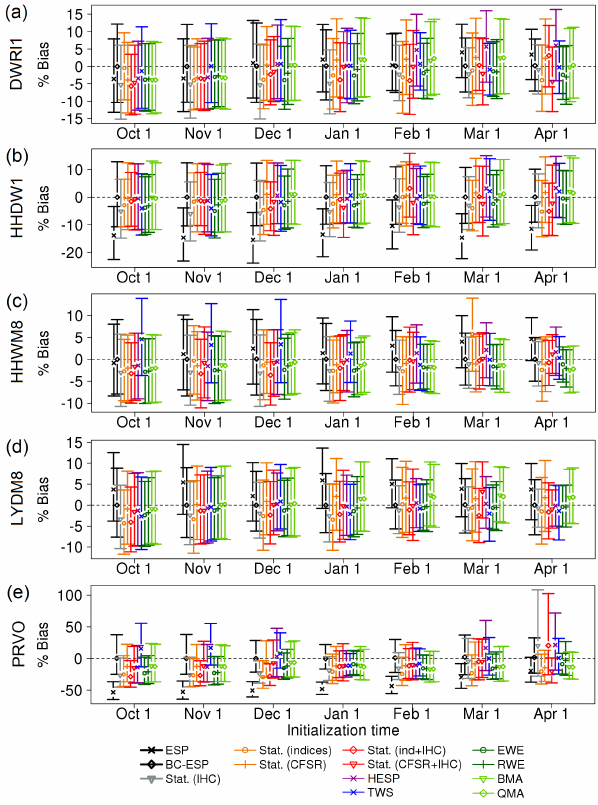
Figure 7. The same as Fig. 5 but for percent bias (% bias) in forecast ensemble medians versus observations. See text for further